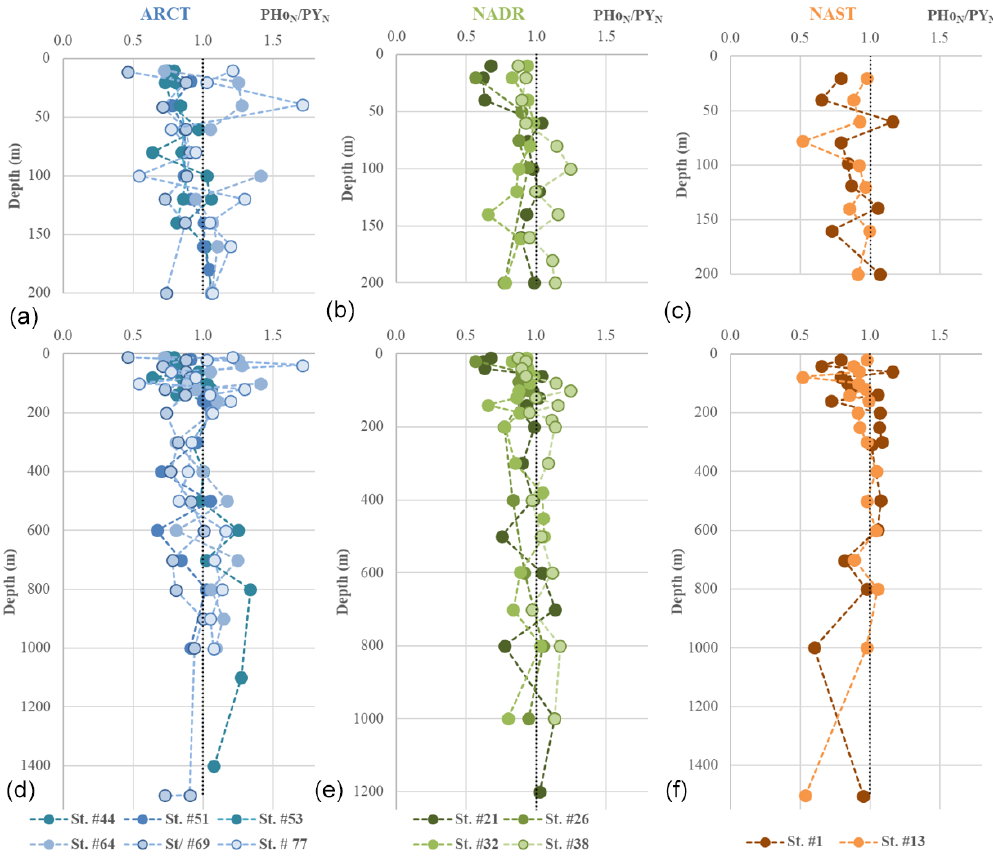
Figure 8. PAAS-normalized PHo / PY profiles grouped by biogeochemical provinces (ARCT, NADR, NAST). (a) , (b) , and (c) present the first 200m and (d) , (e) , and (f) all the data. The dashed black vertical line in each panel represents the PAAS ratio